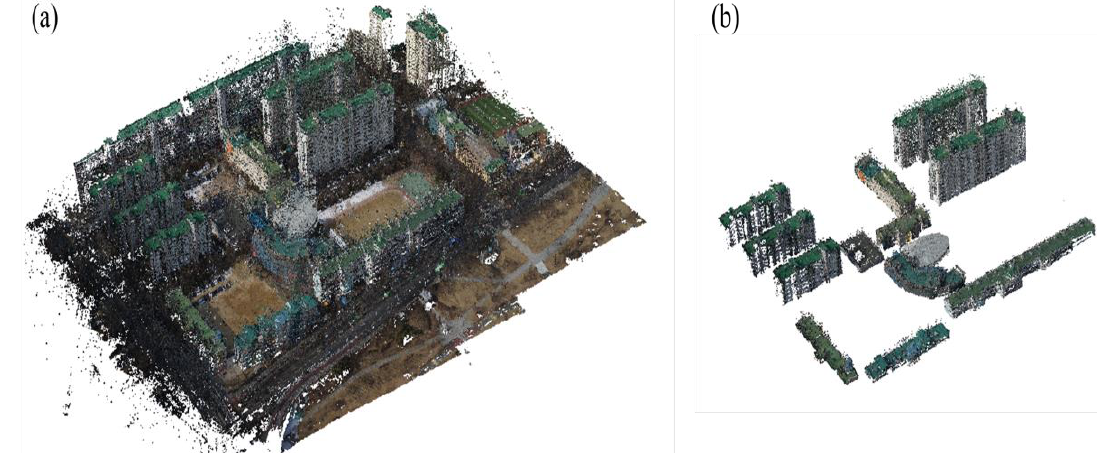
Figure 3. Source point cloud(a) and Ground plane removal